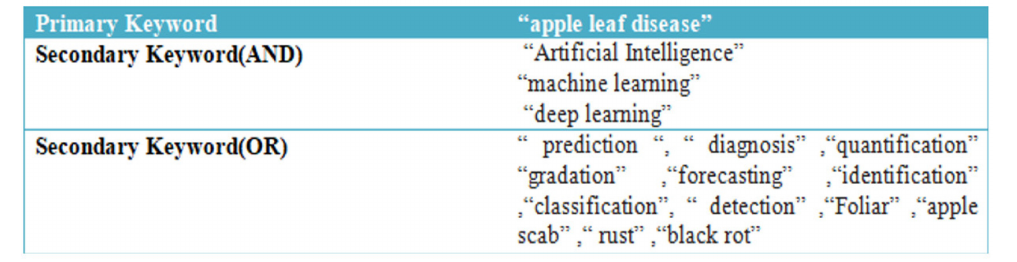
Figure 10. Primary and Secondary Search Strings.